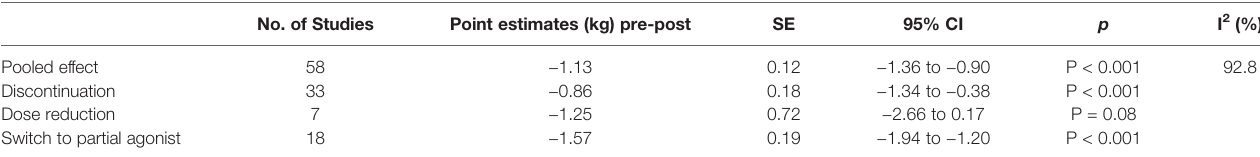
TABLE 3 | Pooled results of secondary outcomes, pooled and grouped by type of intervention) measured in kilograms (kg) with standard error (SE). No. of